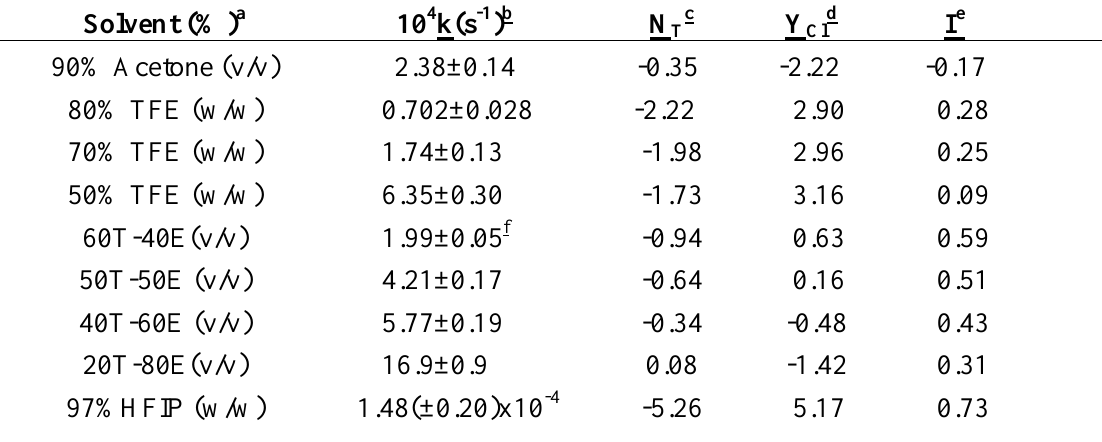
Table 2 . Specific rates of solvolysis (k) for the solvolysis of phenyl chloroformate in several binary ), solvent ionizing power (Y ), and aromatic ring solvents at 25.0ºC and the solvent nucleophilicity (N T Cl parameter (I) values for the